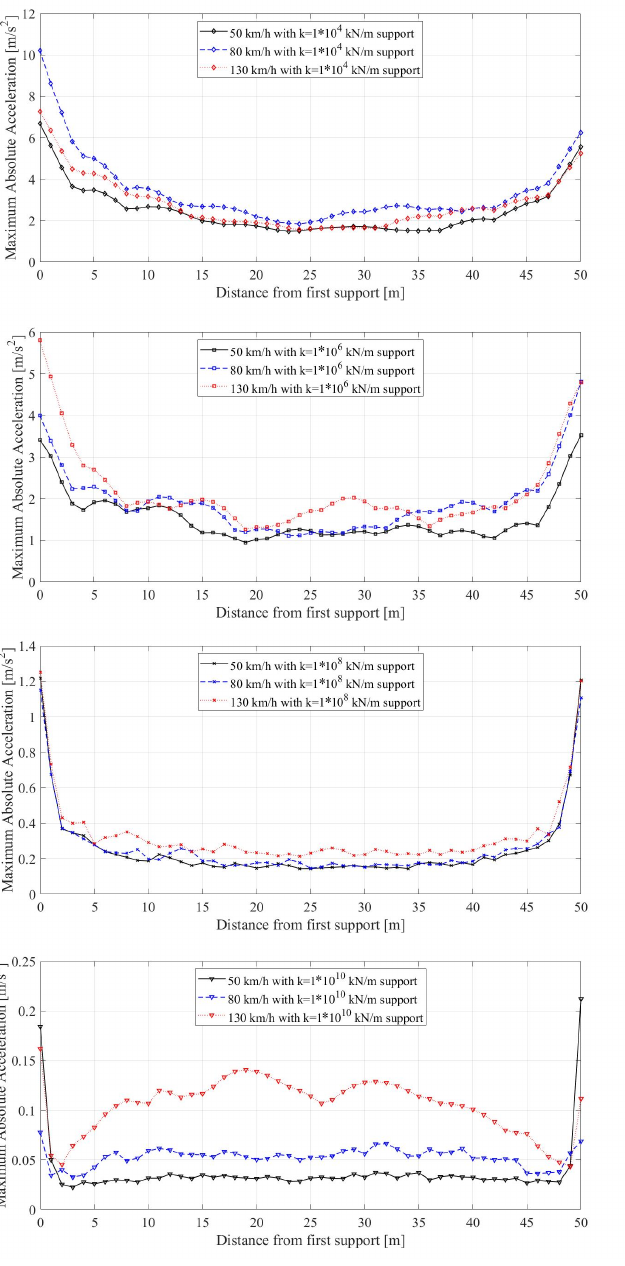
Figure 8. Absolute Maximum Accelerations along the bridge length for different bearing stiffness and train